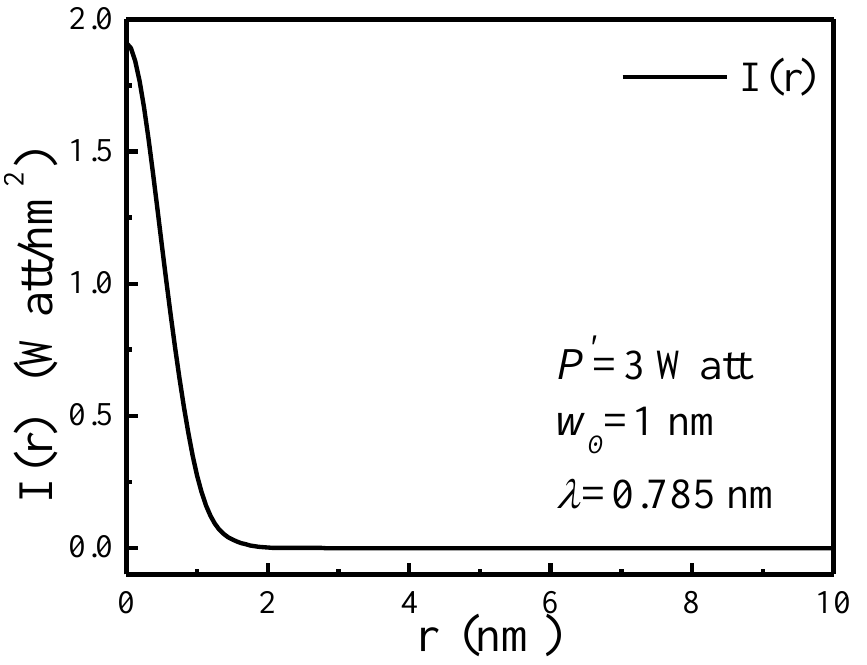
Figure 1. Intensity I(r) of the crossed beam varying with radial distance within the dipole trap. Concerning the trapping of an alkali atom using a far-detuned laser beam having wavelength λ = 0.785 nm, the following points have to be taken into account. As mentioned in the ref. [39], if we prepare the atoms in the excited state, for instance, F = 2 in Rb, a blue detuned laser beam will create a trappable potential. However, the intensity has to be tuned in such a way that the trap depth is appreciable to hold the atom. Hence, selectively one has to choose the atoms and laser intensity appropriately and prepare them in a specific excited state to achieve optical dipole trapping. Note that Equation (4) depicts the dipole trap the atom experiences. However, the potential felt by an atomic electron is calculated as